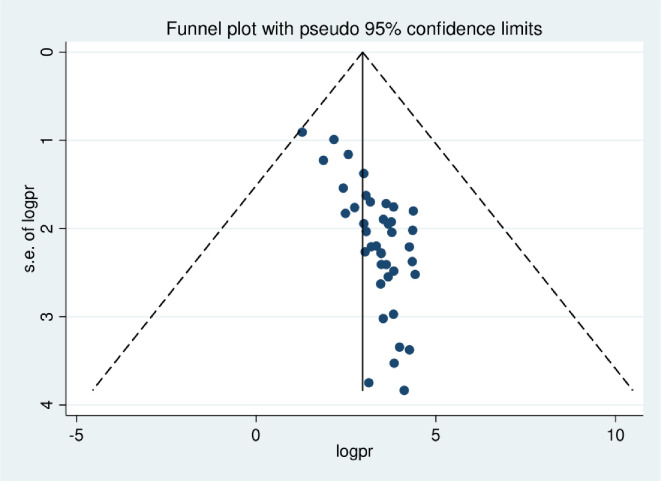
The funnel plot asymmetry for publication bias of the studies included in systematic review and meta-analysis of breast self-examination practice among women in Ethiopia.